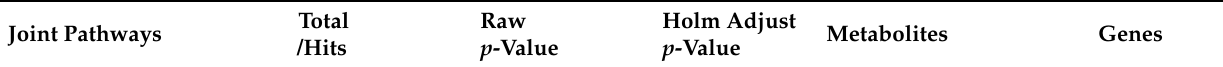
Table 2. Important functional pathways, metabolites, and genes. Important enriched pathways from an integrated analysis of metabolites and genes are divided into the top general functional pathways, top cell signaling and functional pathways, and cancer pathways. Complete statistical detailing of pathways and a list of functional hits along with their regulation statuses are